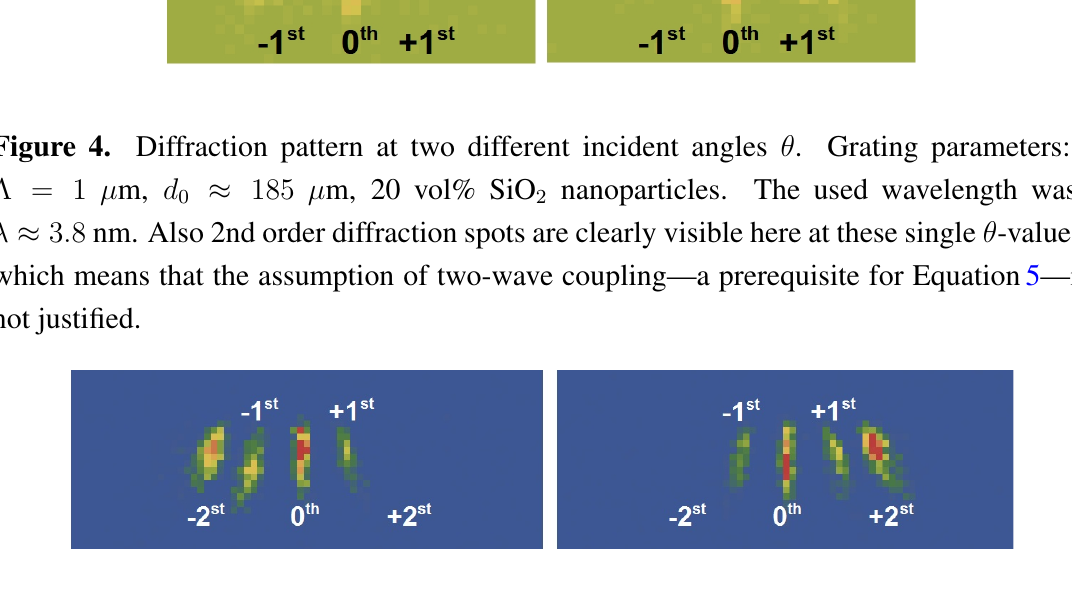
Figure 3. Diffraction pattern of a nanoparticle-polymer composite grating (20 vol% SiO 2 ≈ 108 µ m) set to the Bragg positions. The nanoparticle concentration, Λ = 0 . 5 µ m, d 0 measurement was done with a 3 He multi-wire proportional chamber. The position resolution is 2 × 2 mm 2 . Efficiency: 80% at λ = 4 nm). Only two diffraction spots are observed. The